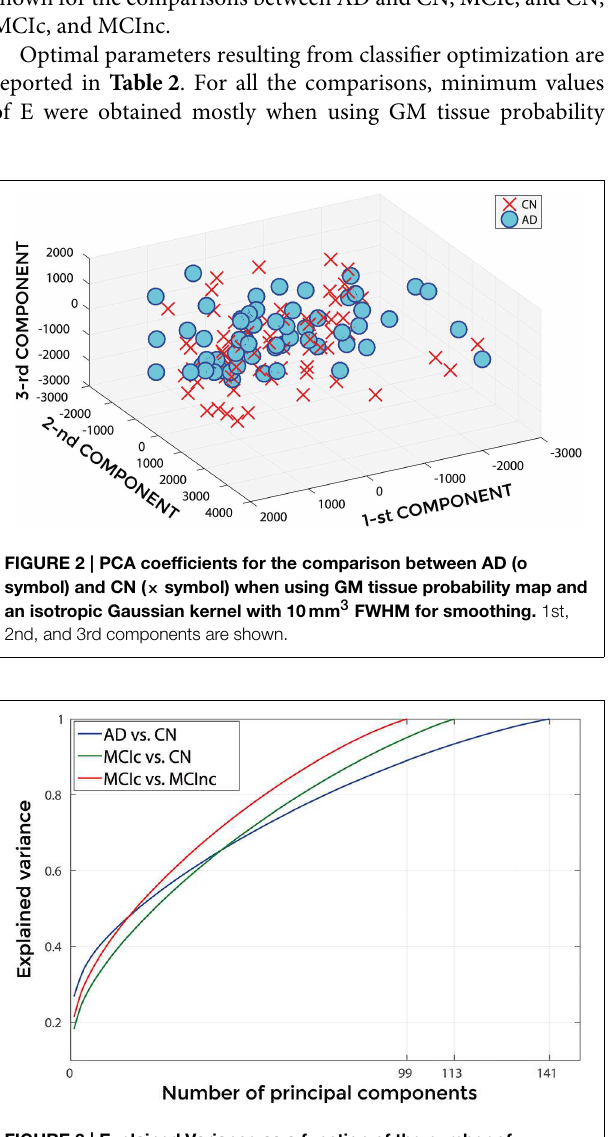
FIGURE 3 | Explained Variance as a function of the number of considered Principal Components, when using GM tissue probability map and no smoothing, for the following comparisons: AD vs. CN, MCIc vs. CN, MCIc vs. MCInc.